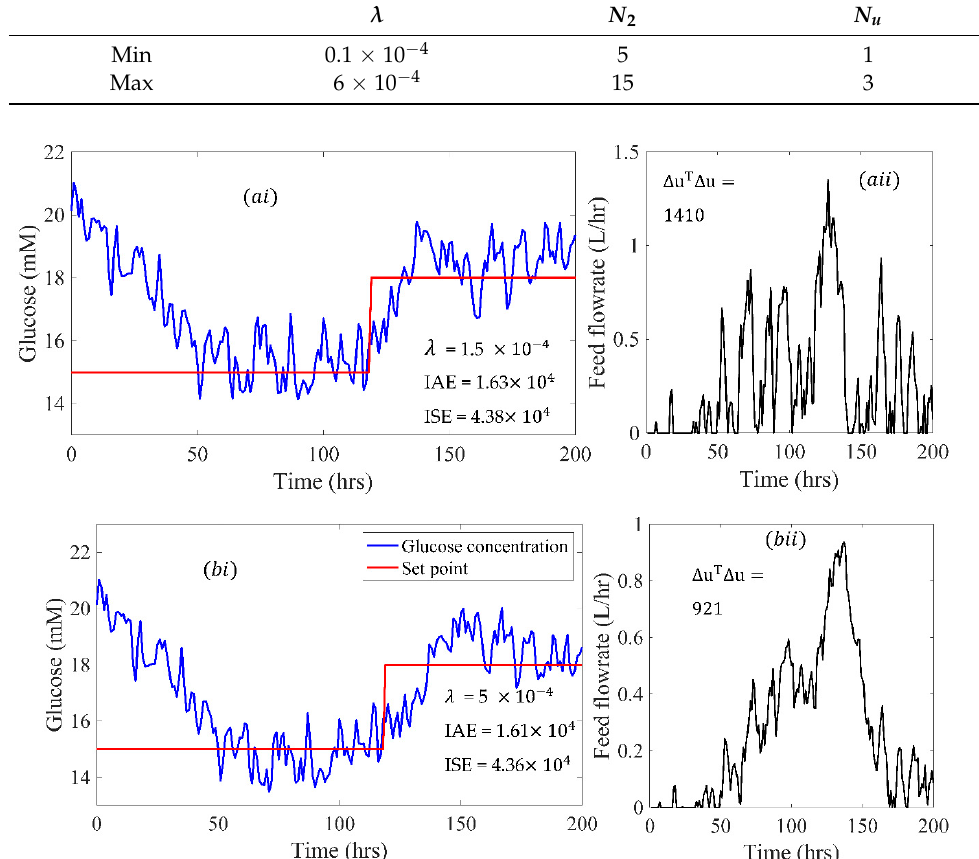
Table 2. The minimum and maximum tuning parameters considered in the factorial design.